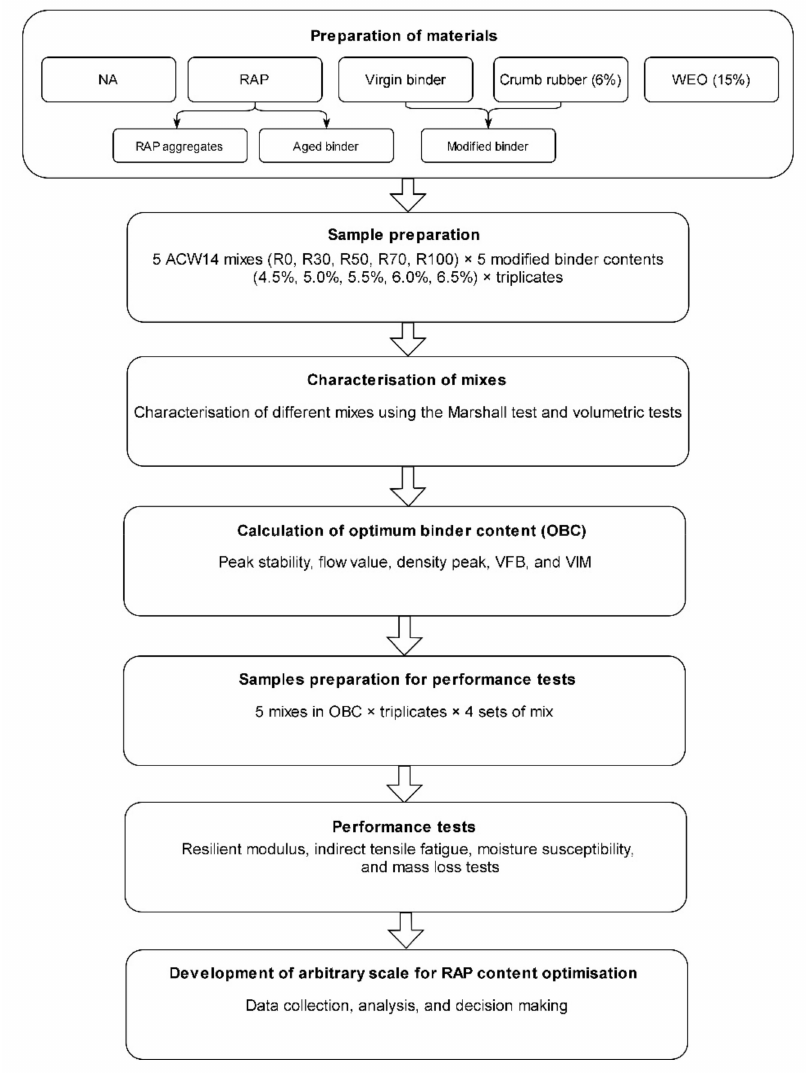
Figure 2. The experimental process in this